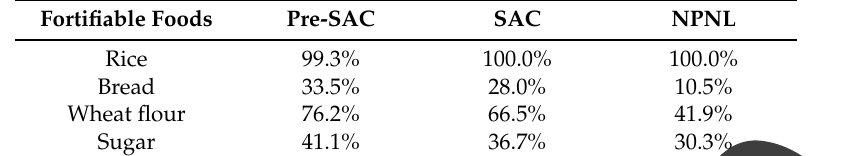
Table 3. Percentage of people consuming rice, bread, wheat flour, and sugar by population group.